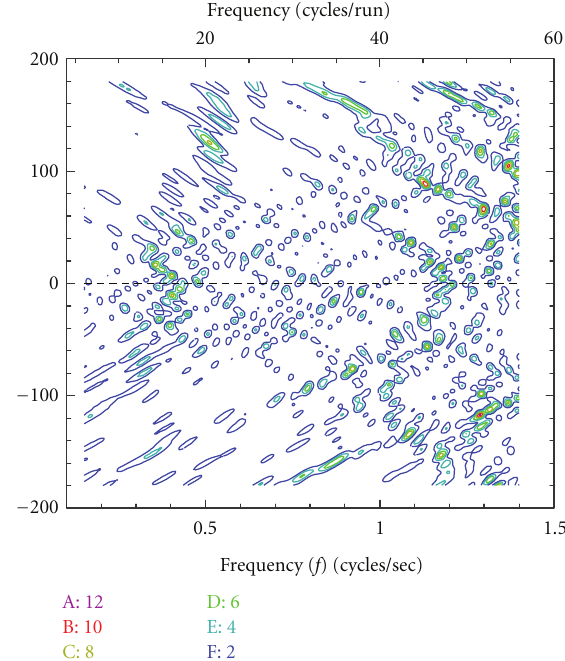
∼ 18,000 events in 40s) is contoured on the frequency-frequency derivative